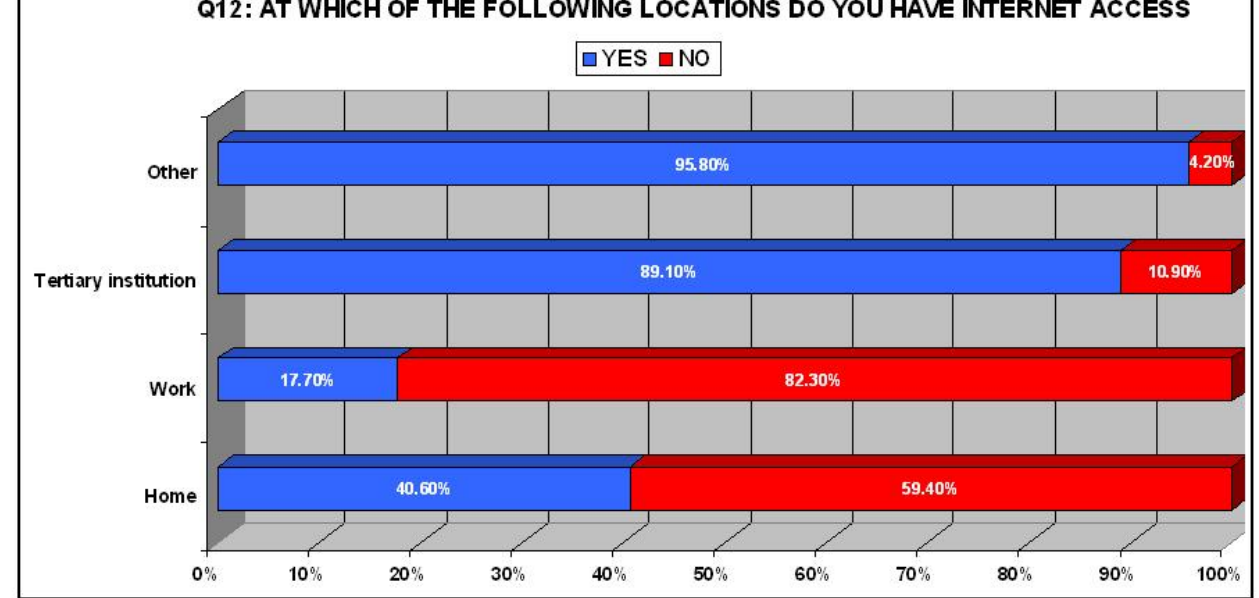
Figure 10 Representation of the responses to Question 3 of the survey